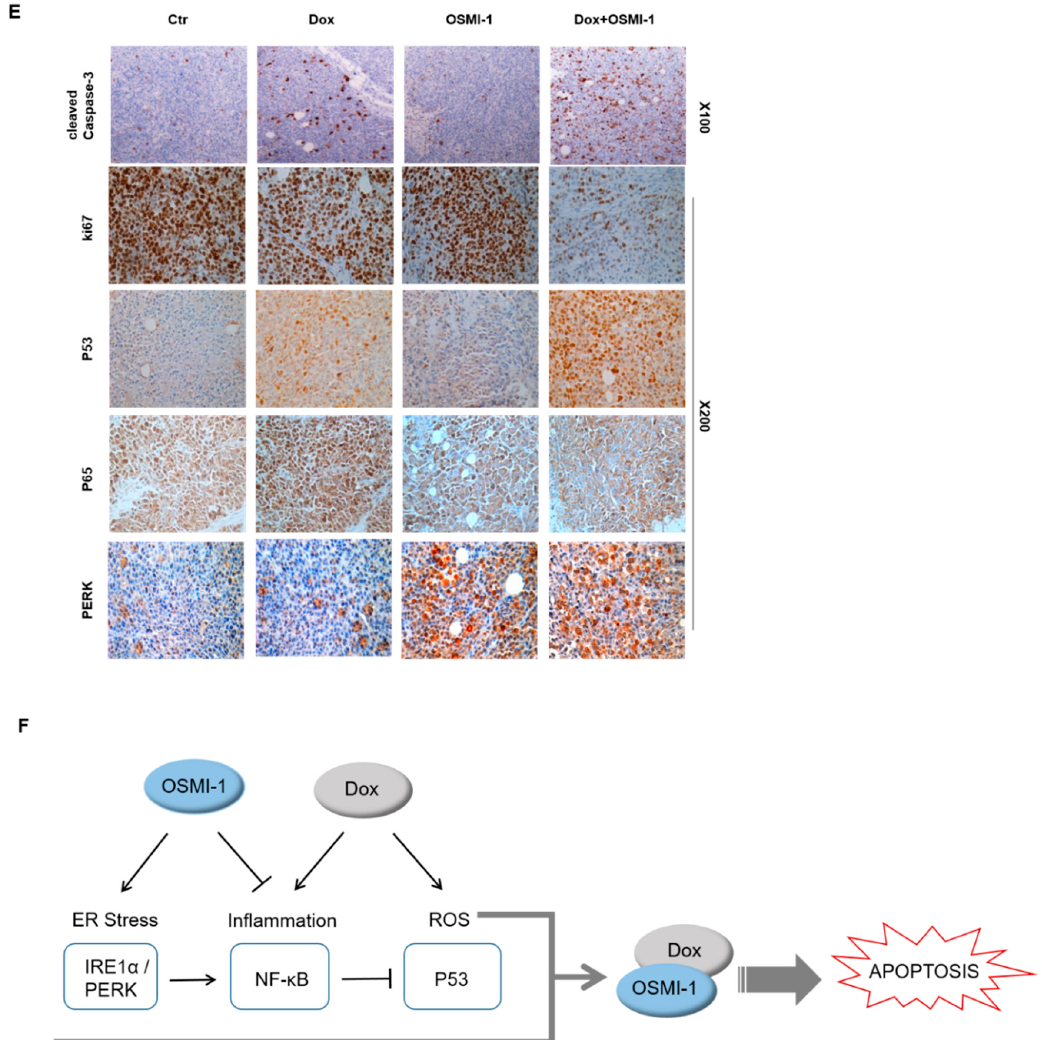
Figure 5. DOX and OSMI combination synergistically inhibited the tumor growth of human HCC xenograft in vivo. ( A ) HepG2 cells were subcutaneously inoculated in nude mice, and tumor growths were monitored for 32 days. Treatments were as follows: vehicle (DMSO, 100 mm 3 ), DOX (0.1 mg / kg), and OSMI-1 (1 mg / kg) singly or in combination by IV injection once per 3 days for 3 weeks. A growth profile of each tumor was recorded and expressed as changes in tumor volume (mm 3 ) at the indicated time points. Data are shown as mean ± standard deviation of three independent experiments. ** p < 0.01 compared with the control group. Representative images of the excised tumors derived from nude mice are shown in the right panel. ( B ) Expression levels of p53, p-p65, p65, cleaved caspase-3, and PARP in the excised tumor tissues derived from nude mice were determined by Western blotting using equivalent amounts of total tissue protein. The expression levels were normalized relative to β -actin. The graphs on the right show the relative amount of measured protein as fold increase. ( C ) As in (A), HepG2 xenograft mice were treated with DOX (1 mg / kg) or OSMI-1 (5 mg / kg) alone or in combination via IV injection, and tumor growth was monitored for 32 days. Volumes of xenograft tumors were measured and plotted at the indicated time points after treatment. Values are presented as means ± SD ( n = 4). * p < 0.05, ** p < 0.01, *** p < 0.005 compared with the control group. Representative images of the excised tumors derived from nude mice are shown in the right panel. ( D ) Expression levels of p53, p21, Bax, cleaved caspase-3, IRE1, and PERK in the excised tumor tissues derived from nude mice were determined by Western blotting using equivalent amounts of total tissue protein. The expression levels were normalized relative to β -actin. The graphs on the right show the relative amount of measured protein as fold increase, the uncropped western blot figures in Figure